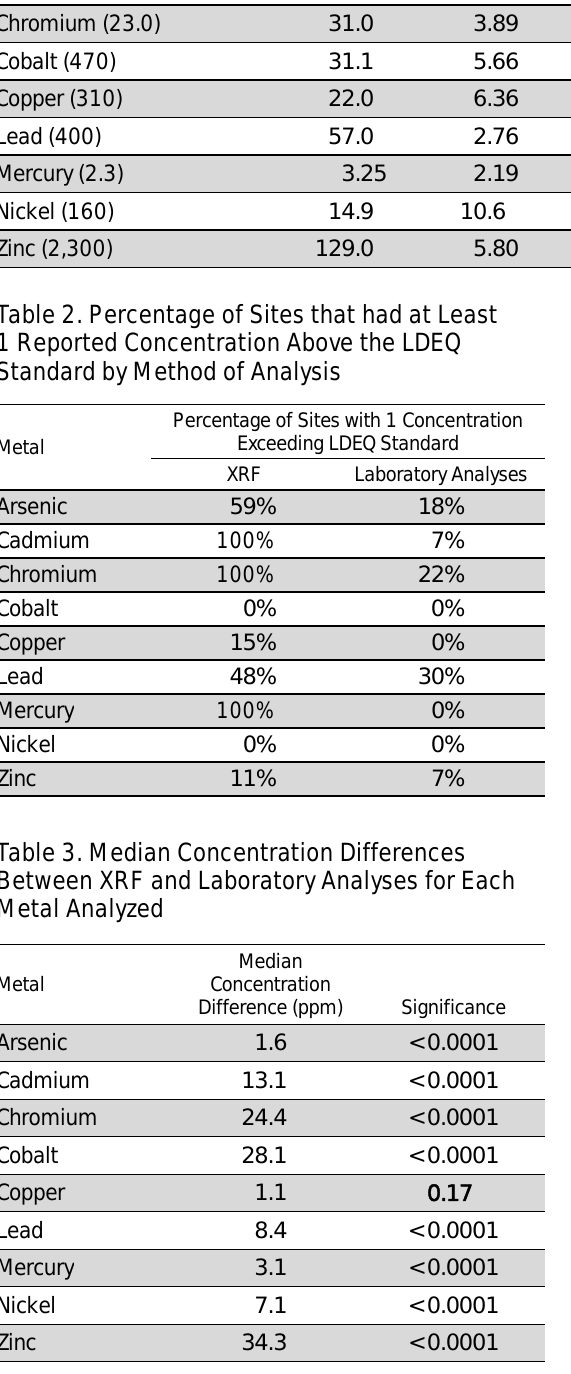
Metal (LDEQ Standard ppm)